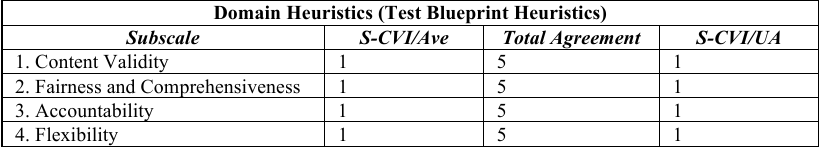
Table 5. Summary of Content Validity Testing Results using Content Validity Index (CVI)